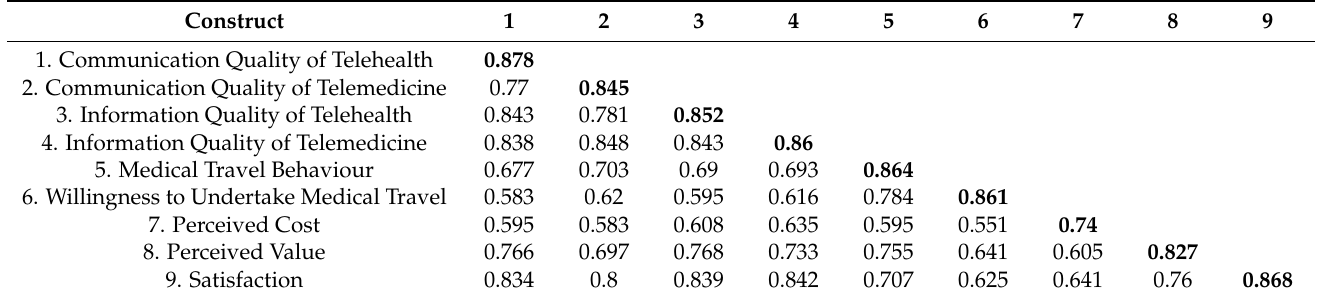
Table 5. Measurement model